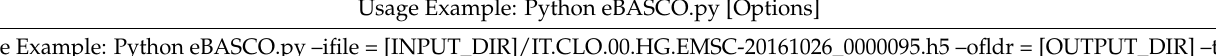
Table A1. Example of a command line to run